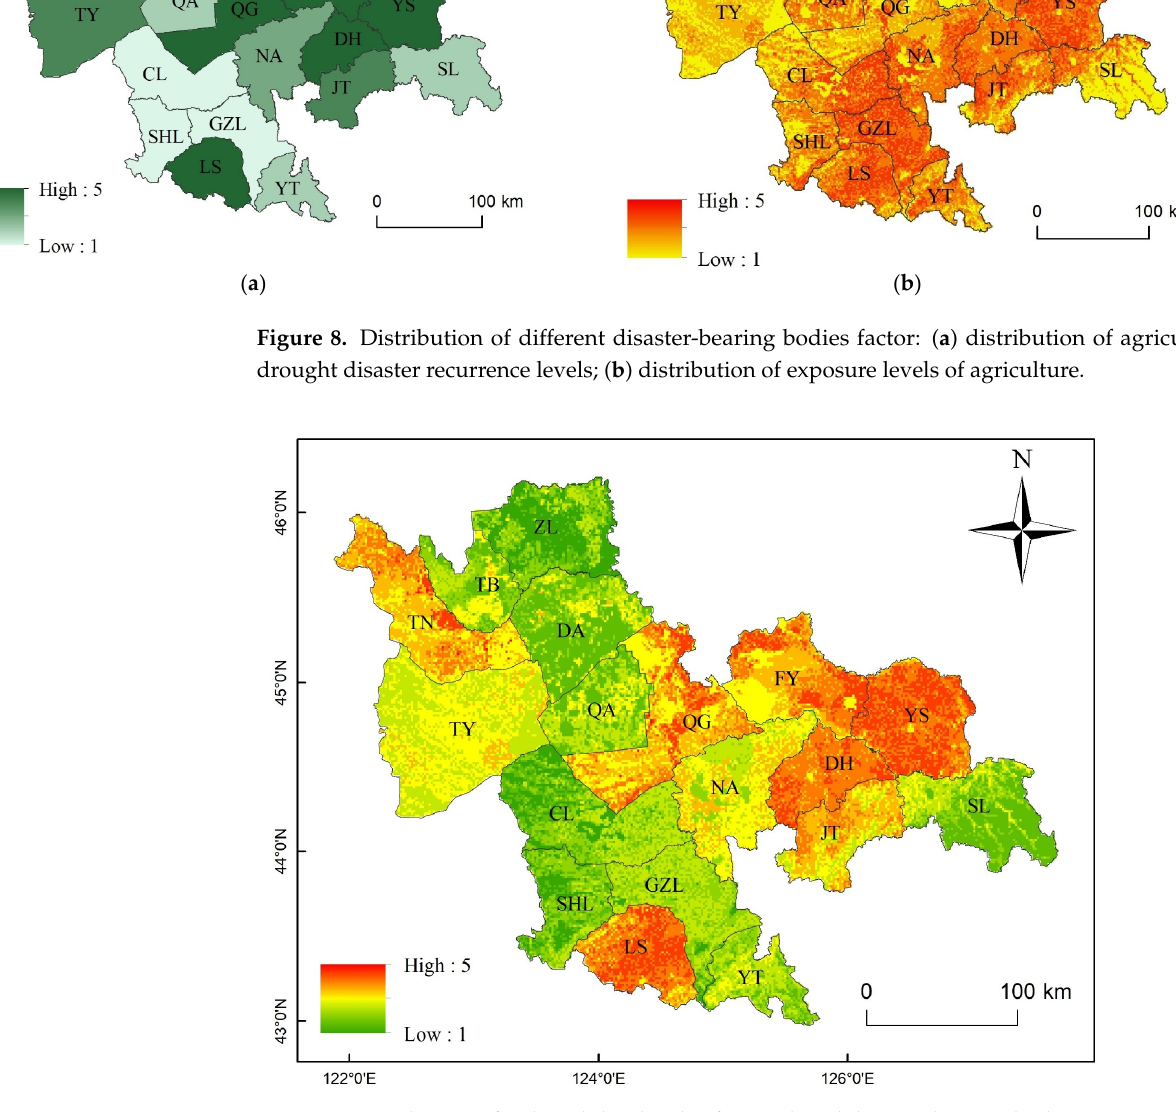
Figure 9. Distribution of vulnerability levels of agricultural disaster-bearing bodies.